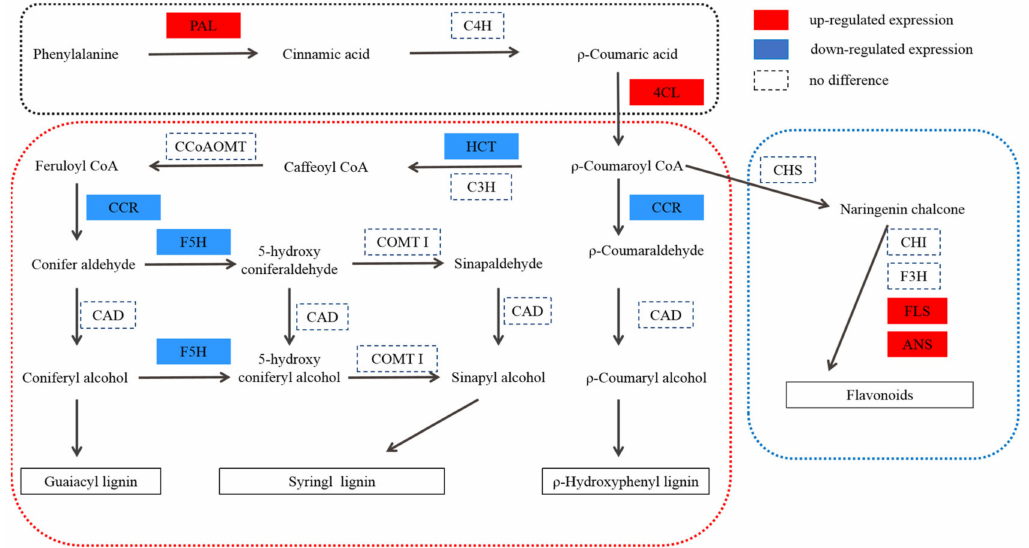
Figure 5. Protein expression patterns of phenylpropane pathway in T51. P-coumaroyl CoA is at the crossroads of metabolic routes leading either to flavonoids or to monolignols. PAL, phenylalanine ammonia lyase; C4H, C4-hydroxylase (CYP73A5); 4CL, 4- coumaroyl-CoA ligase; CHS, chalcone synthase; CHI, chalcone isomerase; F3H, flavanone 3-hydroxylase; FLS, flavonol synthase; ANS, anthocyanidin synthase; HCT, hydroxycinnamoyl CoA:shikimate hydroxycinnamoyl transferase; C3H, C3-hydroxylase (CYP98A3); CCR, cinnamoyl-CoA reductase; CAD, cinnamyl alcohol dehydrogenase; F5H, ferulate 5- hydroxylase (CYP84A1); CCoAOMT, caffeoyl-CoA O-methyltransferase; COMT I, caffeic acid O-methyltransferase of class